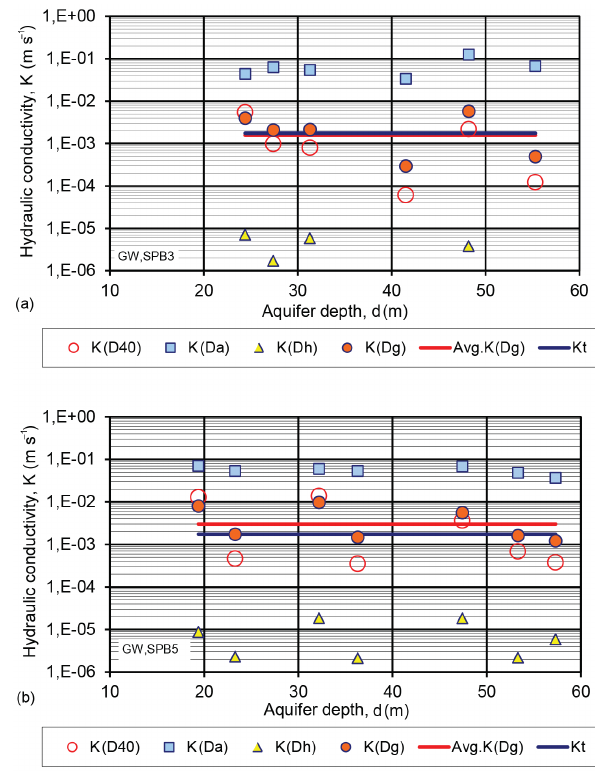
Figure 10. Predicted hydraulic conductivity calculated using the KC equation for samples from the gravelly aquifer (test field GW) – (a) borehole SPB-3; (b) borehole SP B-5.